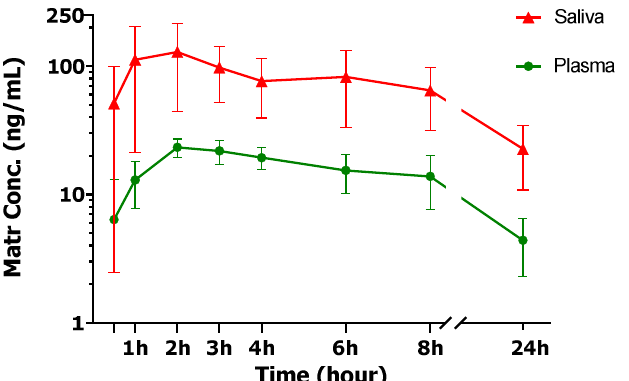
Figure 3. Plasma and saliva concentration-time profiles of Matr after single dose administration of ATB in healthy human volunteers ( n = 8). Each data point represents the mean of individual plasma/saliva of 8 subjects with error bar (standard deviation). Table 5. Pharmacokinetic parameters of matrine in human plasma and saliva.